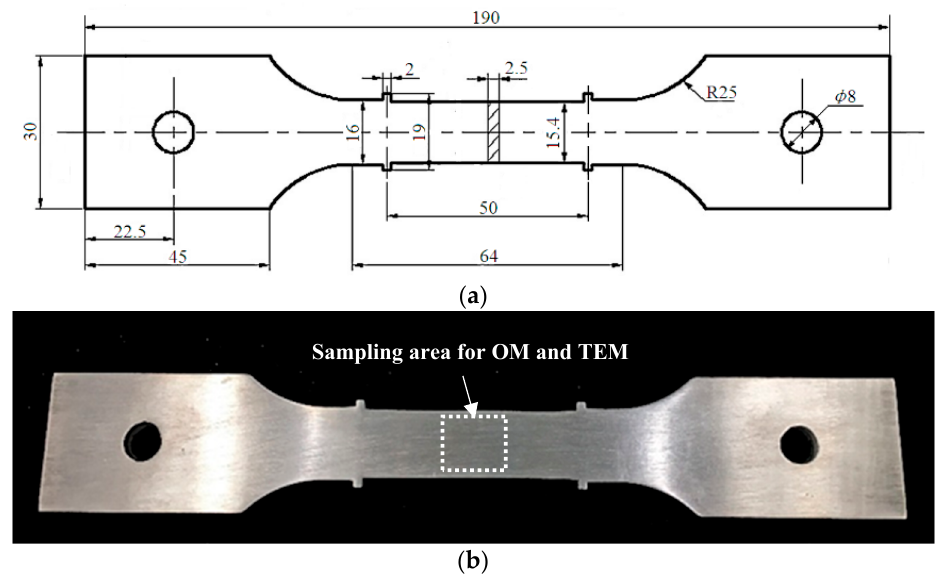
Figure 1. ( a ) Specimen geometry for creep aging tests (unit: mm); ( b ) sampling area of the microstructure specimens (OM and TEM).